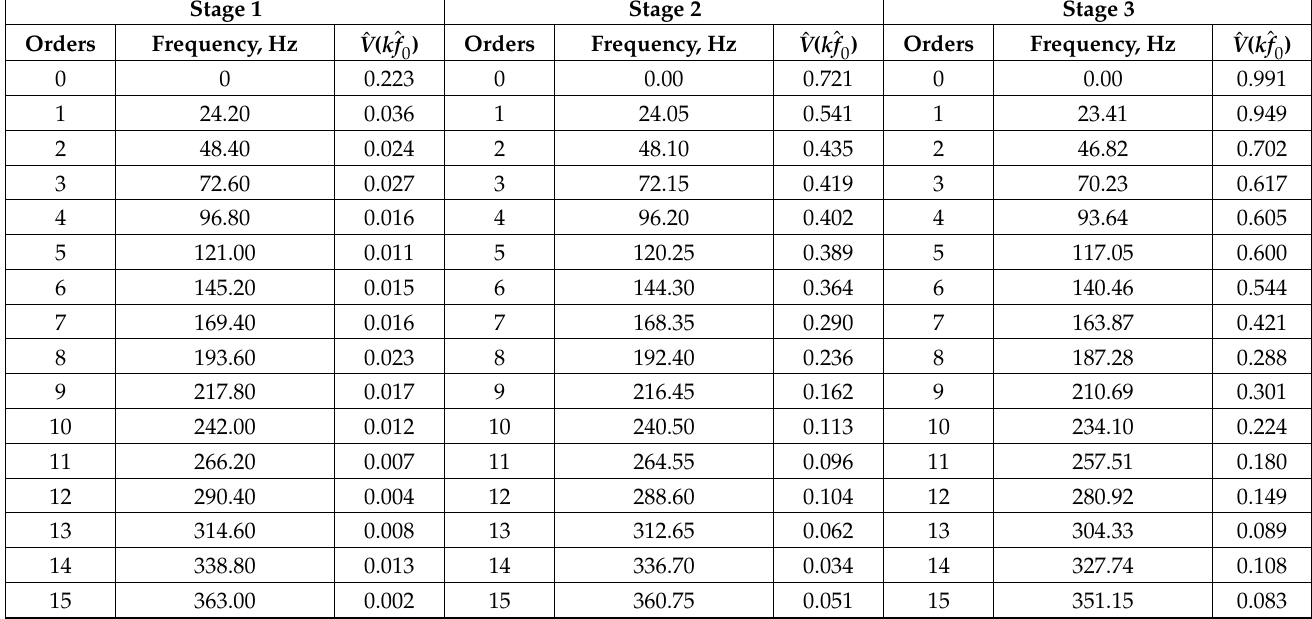
Table 2. Amplitudes of the variances time variety.